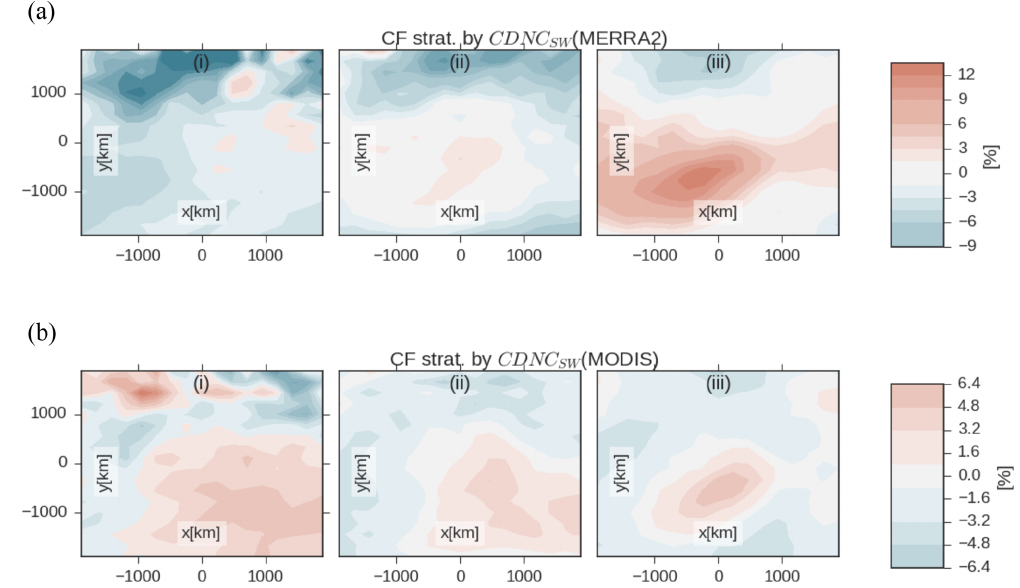
Figure 9. As in Fig. 7, but showing differences in cloud fraction.